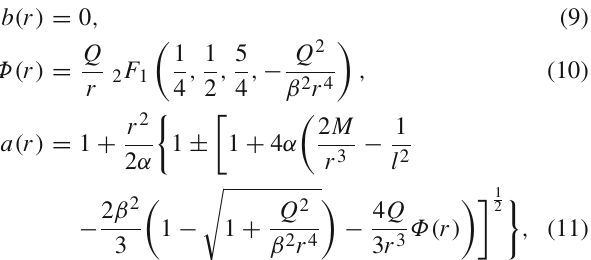
black holes in the novel 4D EGB gravity and GR are also plotted for comparison. As shown in the figures, similar to theRN blackhole, thesolution(11) canhavezero, one, or two horizons depending on the parameters. However, the metric function a ( r ) always approaches a finite value a ( 0 ) = 1 at the origin r → 0 in the novel 4D EGB gravity. This property is different from the BI charged AdS black hole in EBI theory [70], where there are different types of solutions relying on the parameters: a “Schwarzschild-like” type for ( 0 ) → −∞ ), an “RN” type β < β B (only one horizon with a for β > β B (naked singularity, one or two horizons with a ( 0 ) → +∞ ), and a “marginal” type for β = β B (naked singularity or one horizon with a finite value a ( 0 ) = 1 − 2 β B Q ). Interestingly, as shown in Fig. 1(b), even the solution coupledtotheMaxwellfieldbecomesnakedsingularities,the ones coupled to the BI field are still regular black